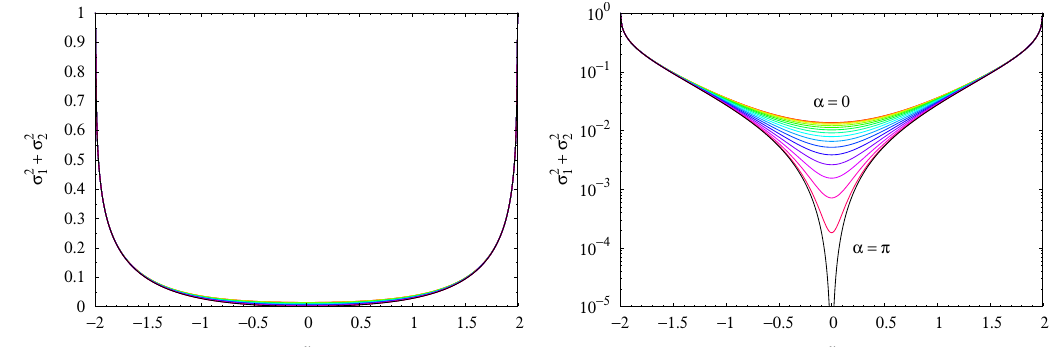
Figure 3. The function (cid:27) 1 ( x ) 2 + (cid:27) 2 ( x ) 2 is shown in a normal plot (left) and on a logarithmic scale (right), for various values of (cid:11) for L = 4 and (cid:3) = 1. The values of (cid:11) are 0 ; (cid:25) top to the bottom curves. The colors are shown in the legend of (cid:12)gure 5.